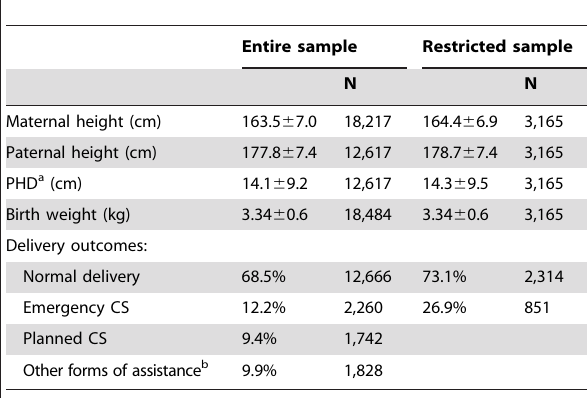
Table 1. Characteristics (mean 6 standard deviation or %) of the entire cohort and the sample used for our